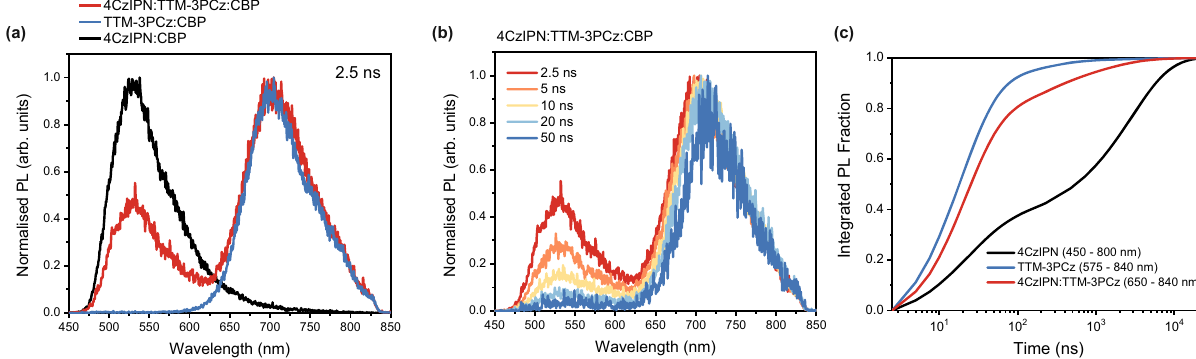
Fig. 2 Transient photoluminescence studies of 4CzIPN and TTM-3PCz with 355 nm excitation. a PL timeslices at 2.5 ns for 4CzIPN:TTM-3PCz:CBP (ratio = 0.25:0.03:0.72, red line); 4CzIPN:CBP (0.25:0.75, black line); TTM-3PCz:CBP (0.03:0.97, blue line), showing emission from both TADF and radical in the combined fi lm. b PL timeslices for 4CzIPN:TTM-3PCz:CBP at various times from 2.5 to 50 ns, showing the 4CzIPN emission decaying relative to the radical emission at longer times. c Integrated PL fraction time pro fi les from 2.5 ns to 25 µ s for 4CzIPN:TTM-3PCz:CBP in 650 – 840 nm range (red line); 4CzIPN:CBP in 450 – 800 nm range (black line); and TTM-3PCz:CBP in 575 – 840 nm range (blue line), showing faster luminescence for the combined TADF:radical fi lm than the TADF-only fi